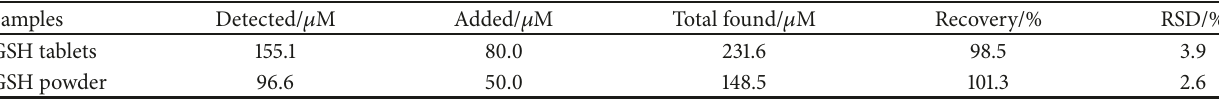
Table 1: Determination of GSH in practical samples (n=5).